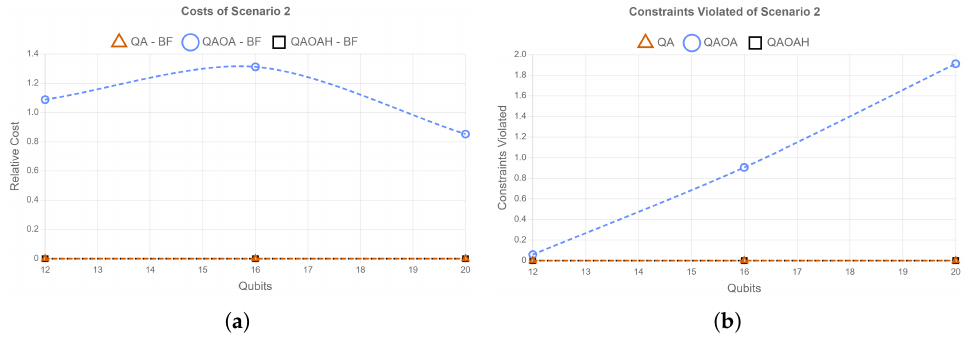
Figure 9. QPU and Simulated Results ( a ) Average relative cost versus the number of qubits used. The relative cost is the mission cost obtained minus the lowest possible mission cost that can be achieved (while keeping constraints) for the problem. The lowest possible cost is found by brute force. Negative relative costs must mean that the solution violated constraints. ( b ) Average number of constraints of each method versus the number of qubits used. The number of constraints counts up how many extra qubits are within a column in the matrix view representation plus the absolute difference of qubits within a row between resource sets ( R 1 and R 2 ). This count includes the number of columns that do not have any qubits on at